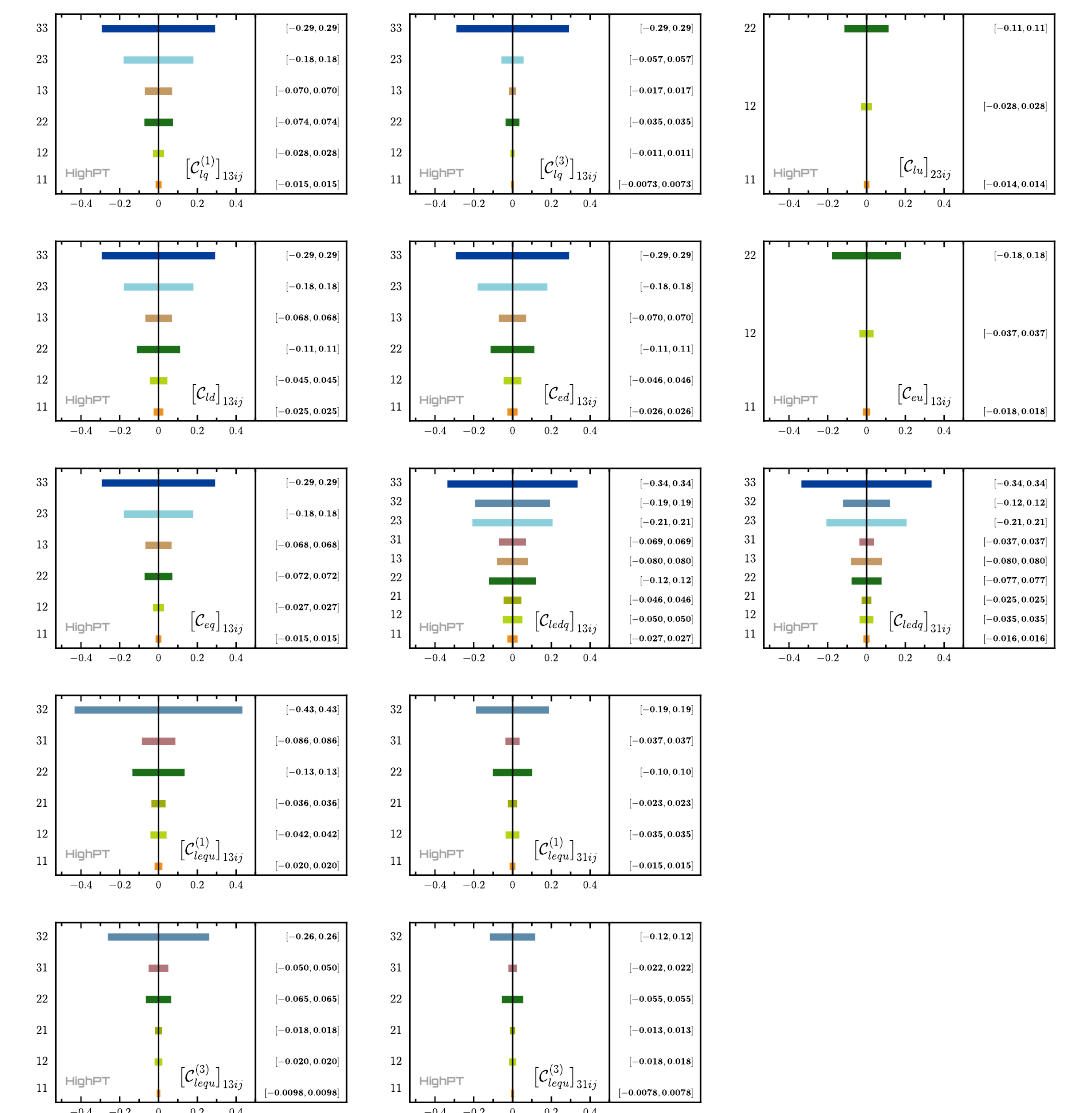
Figure 18. LHC constraints on ψ 4 semileptonic d = 6 Wilson coefficients with eτ flavor indices, where a single coefficient is turned on at a time. See caption of figure